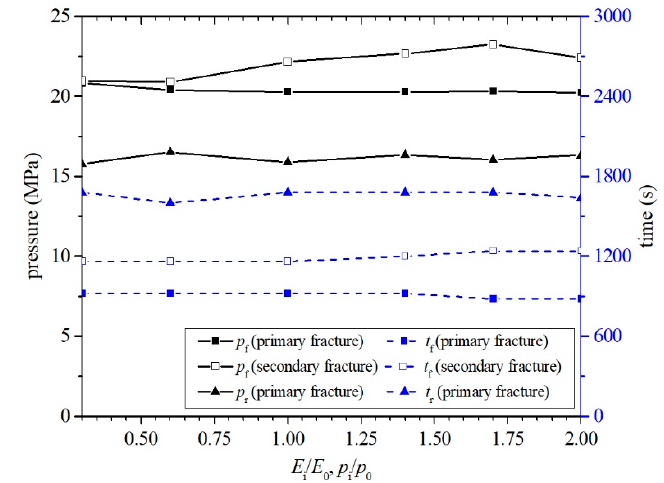
Figure 7. The fracture radius of models with different interlayer Young’s modulus and strength at t = 2000 s (the primary fracture curves are redrawn from [67]).